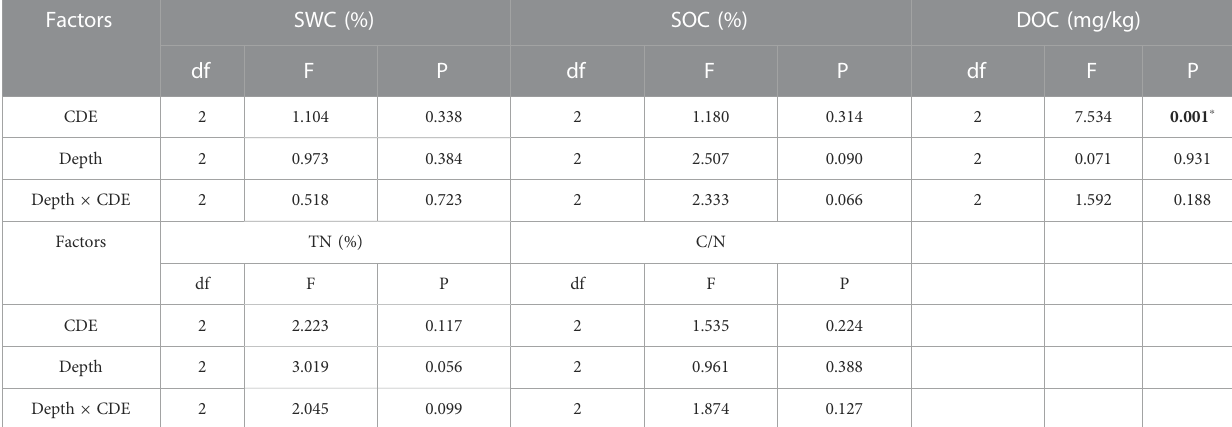
TABLE 2 Impacts of soil depth and CDE on soil properties.